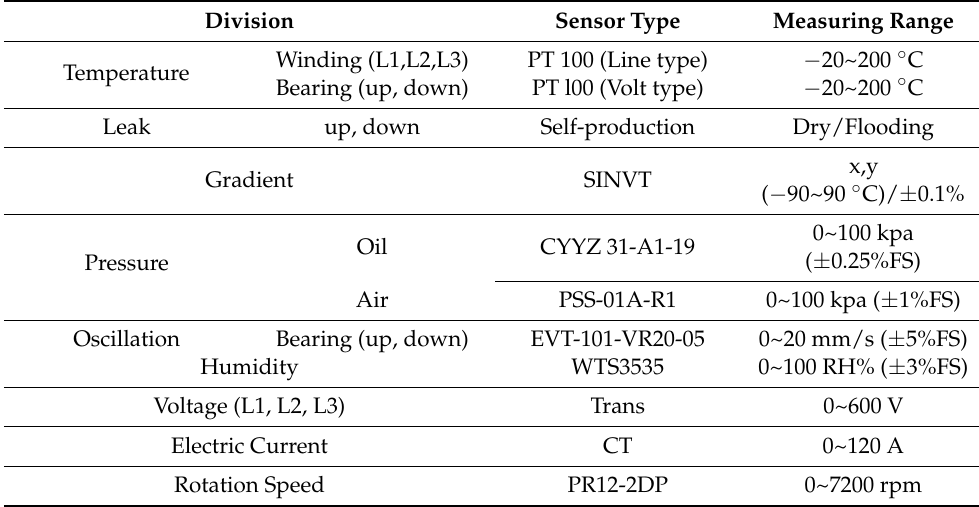
Table 1. Tables should be placed in the main text near to the first time they are cited. Division